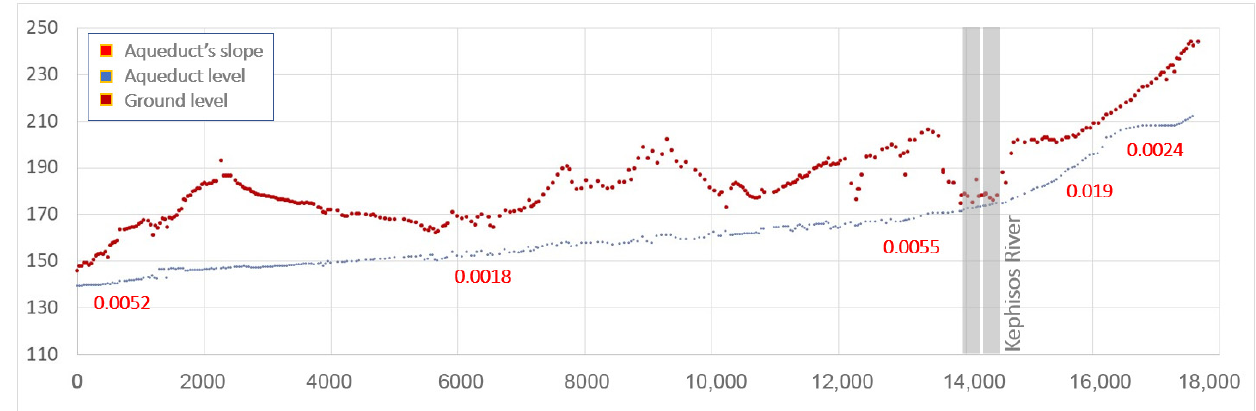
Figure 14. Profile of the aqueduct from Olympic Village to Agios Demetrios. Horizontal axis, the length of the aqueduct in meters; vertical axis, the altitude in meters.